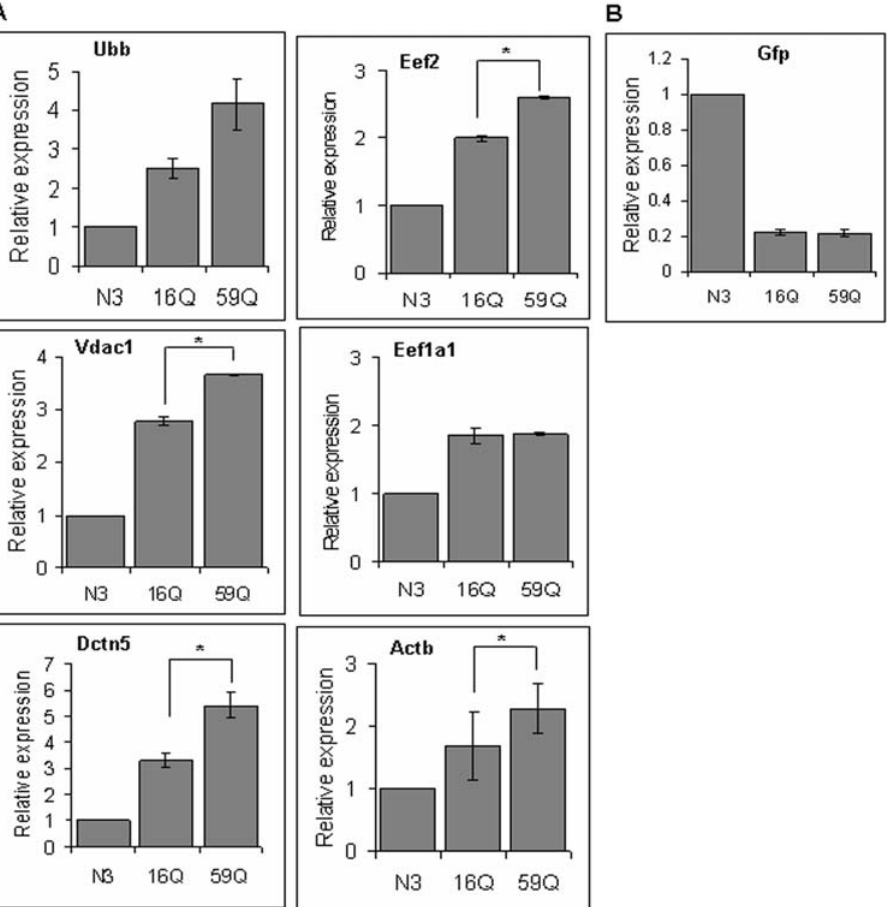
Figure 2. Real time PCR analysis of gene expression. (A) Differential gene expression of Ubb, Vdac1, Dctn5, Eef2, Eef1a1 and Actb in Neuro-2a cell line trasfected with human TBP (hTBP) containing different lengths of polyglutamine. Mouse 18s rRNA was used as an endogenous reference. N3 was used as a calibrator for determining relative expression. (B) Expression levels of reporter (Gfp) in transfected Neuro-2a cells determined by Real time PCR: similar levels of expression of TBPGFP in 16Q and 59Q transfected cells. N3: tranfected construct contains GFP; 16Q, 59Q: transfected construct contains GFP tagged hTBP with CAG repeat length 16 and 59 respectively. Data shown are the mean 6 SEM of two to four independent experiments. (*, p , 0.05, Student’s